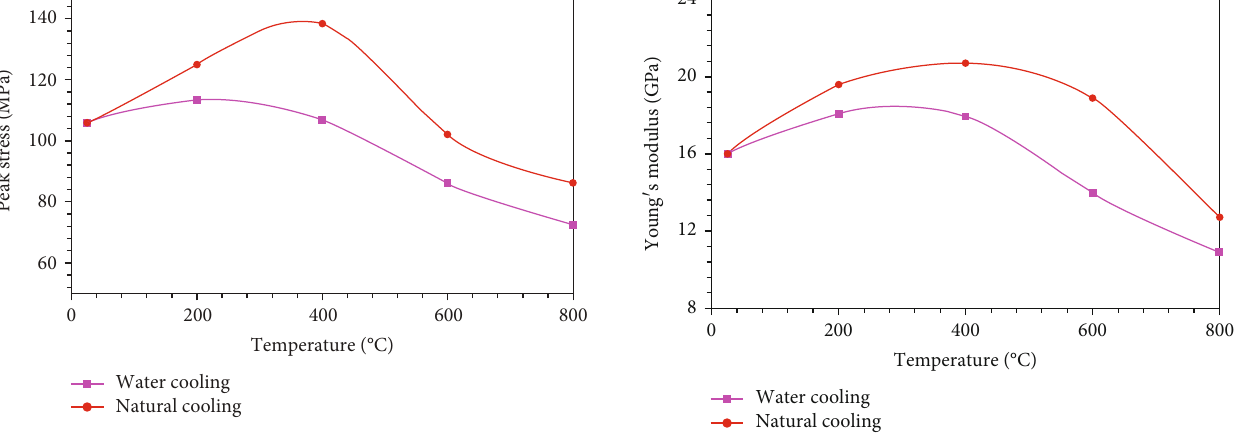
Figure 9: The variations of elastic modulus of core samples with temperature under two di ff erent cooling methods.